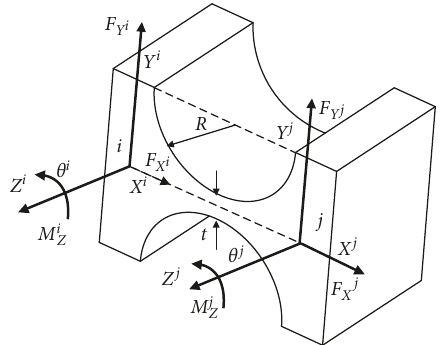
Figure 8: Schematic of the right circular flexure hinge.